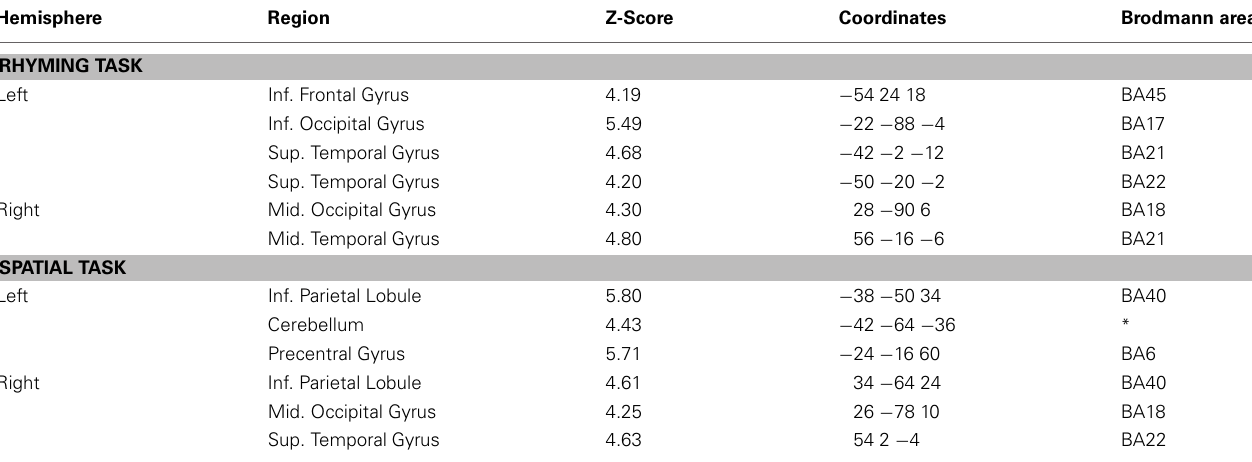
Table 4 | ANOVA Indicated activation peaks for word and spatial tasks. Hemisphere Region Z-Score Coordinates Brodmann area RHYMING TASK